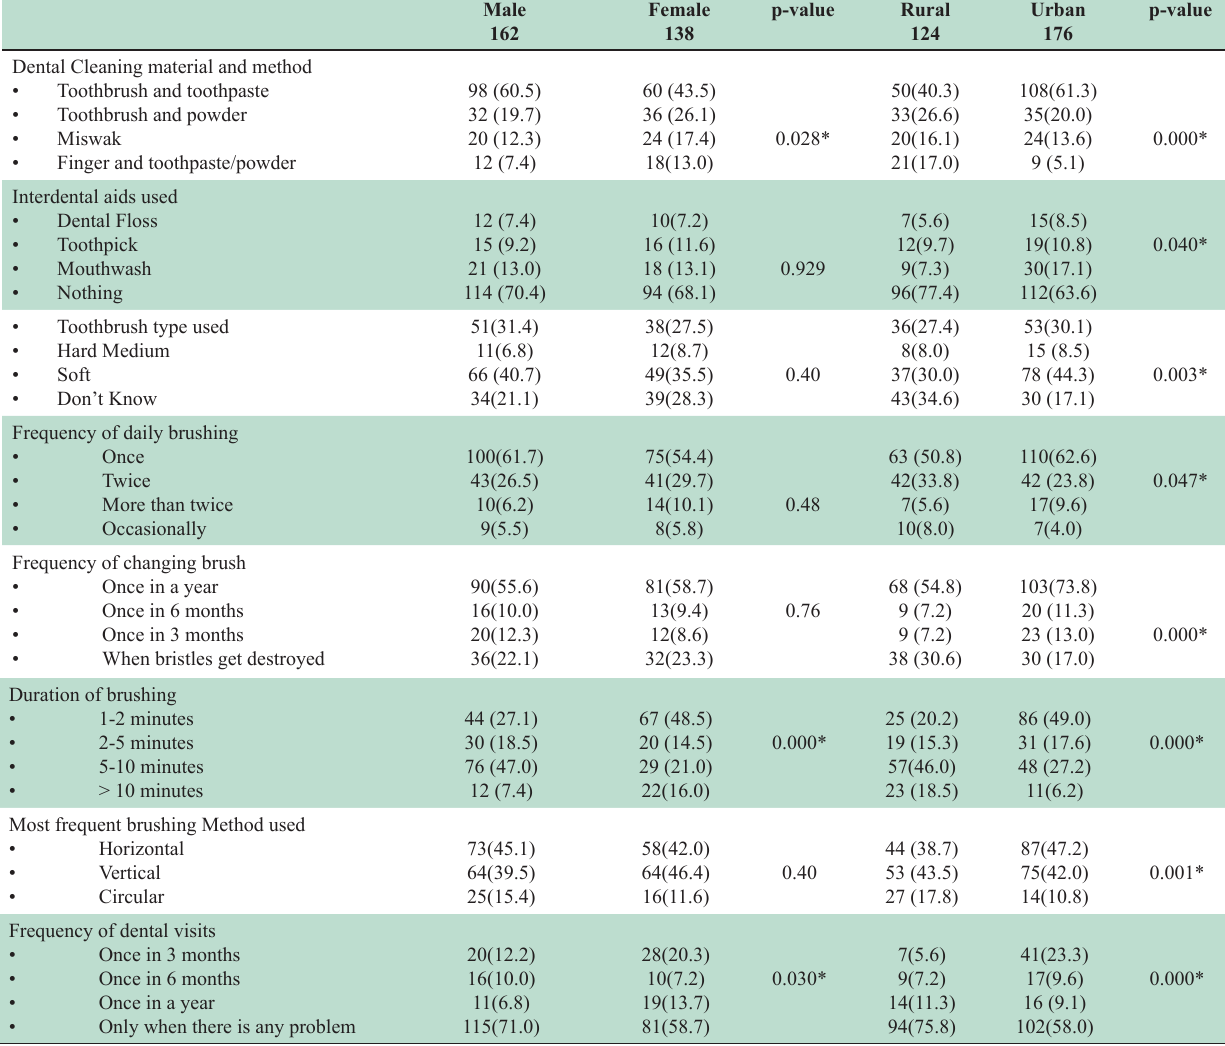
Table-III: Comparison between oral hygiene habits / practices among study participants